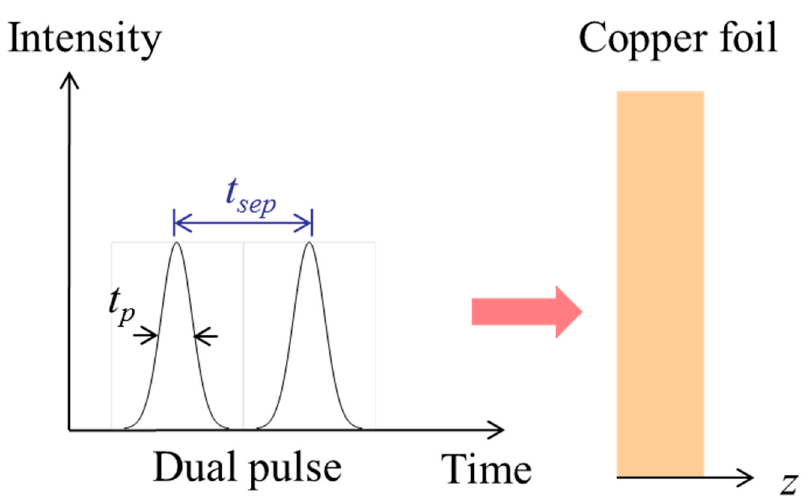
Figure 1. Dual-pulse femtosecond laser irradiated on copper surface.